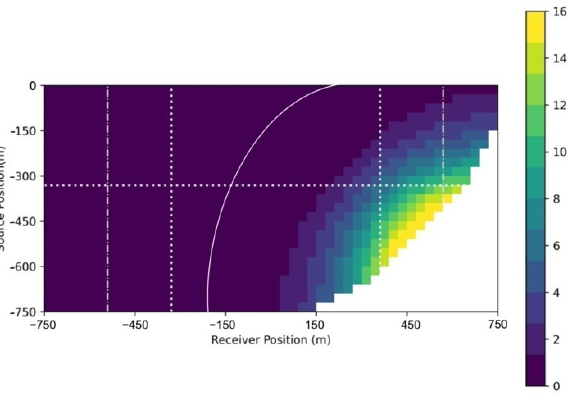
Figure 10. Amplitude of the normalized difference in the electric field at 24 Hz.